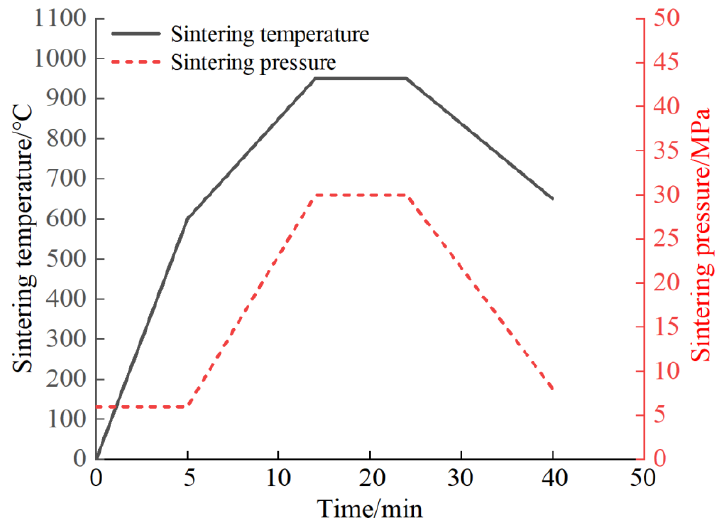
Figure 1. Sintering process curve of a Cu-W composite. The relative densities of the Cu-W composites were measured via the Archimedes Table 1. Parameters of the electrical contact test. method. A microhardness tester (Model: HVS−1000 , Yantai, China) was used to measure hardness with a 200 g indenter load. A conductivity meter (Model: Sigma 2008B, Kawa-